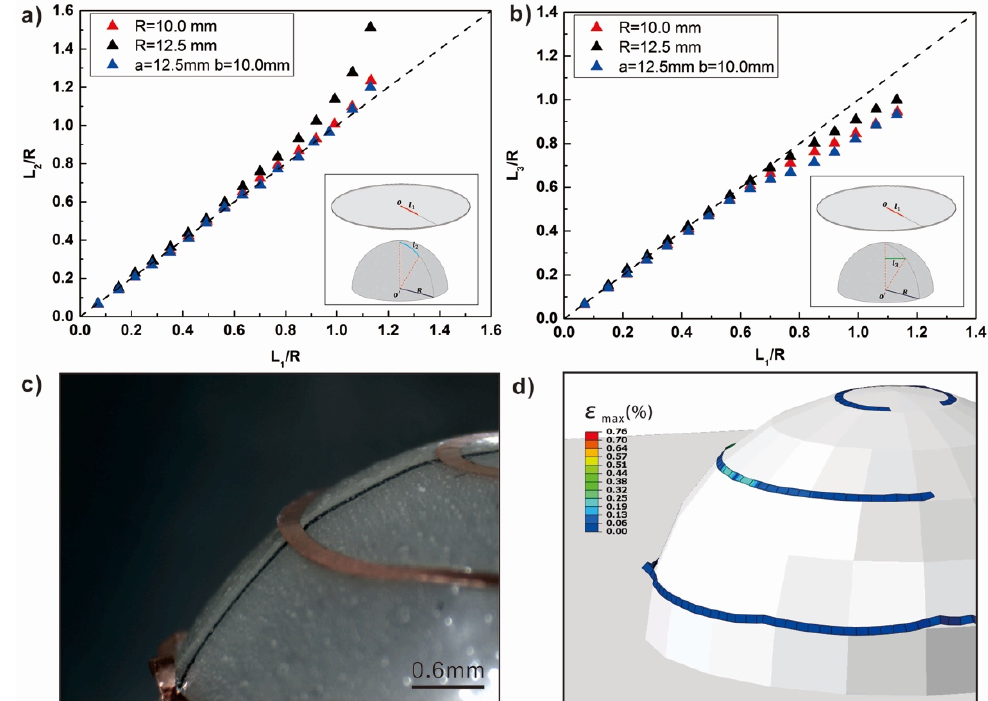
Figure 3. The elongation principles of the thermal bonding films and PC-laminated structures after thermoforming: ( a ) The radial elongation ratio from the top to the edge for three models with different morphology; ( b ) the circumferential shrinkage ratio from the top to the edge for three models with different morphology; ( c ) photos of circuits at different heights; and ( d ) FEM results of circuit stress distributions.